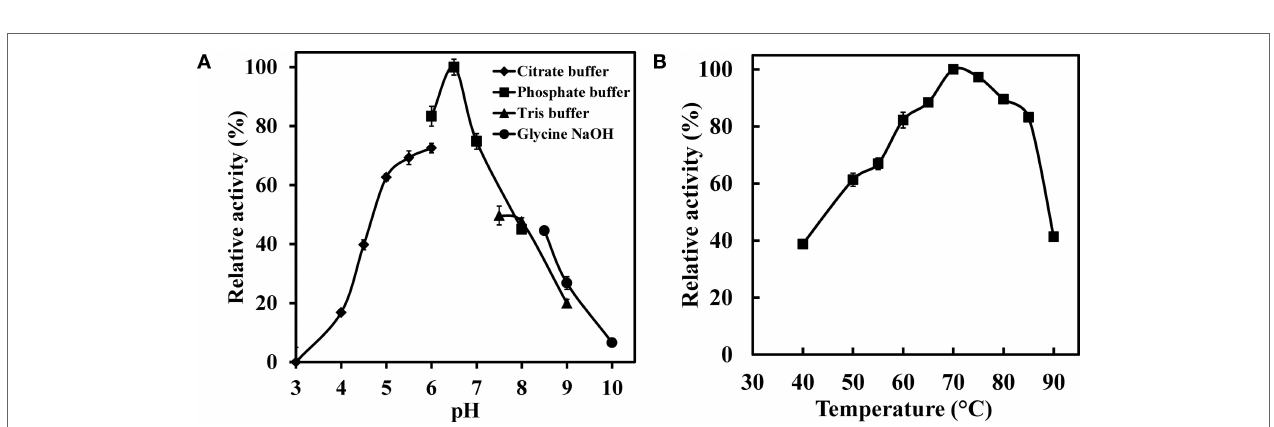
FigUre 4 | impact of (a) ph and (B) temperature on the xylanase activity of WsUcF1 isolate . The enzyme activity was expressed as percentages of the maximum activity. The points are the averages of triplicates, and error bars indicate ± SDs of the means ( n = 3). Error bars smaller than the symbols are not